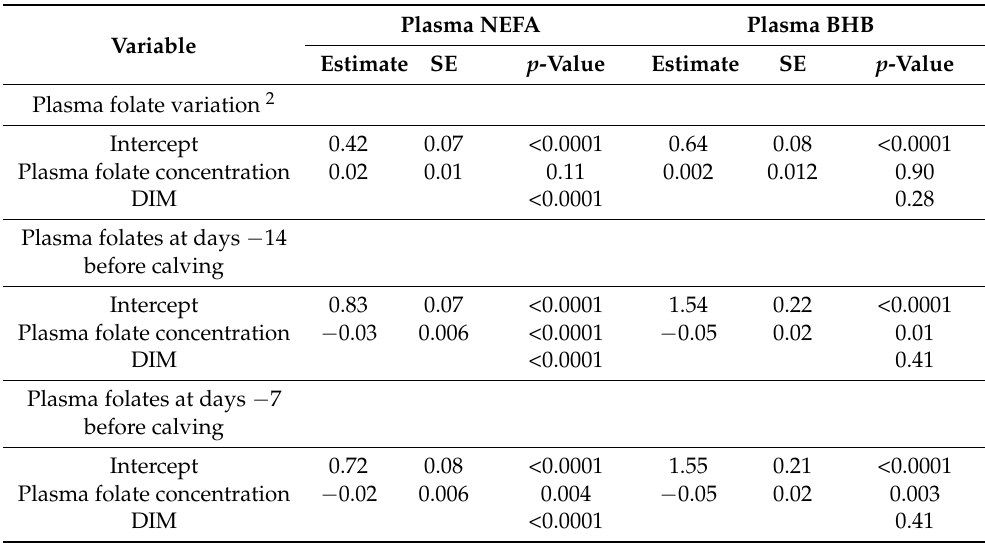
Table 3. Relationships between postpartum plasma NEFA and BHB concentrations 1 and prepartum plasma folate concentration and its variation from − 14 to 21